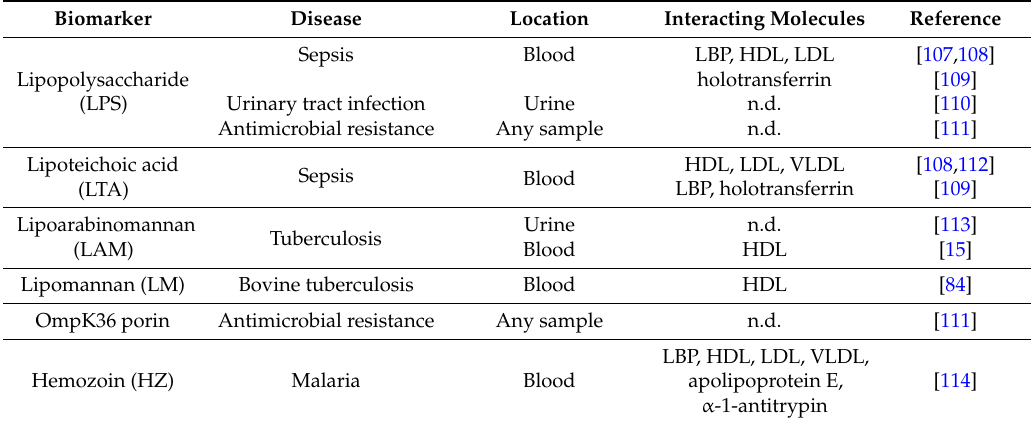
Table 2. Select lipid and amphiphilic biomarkers used for the diagnosis of infectious diseases.